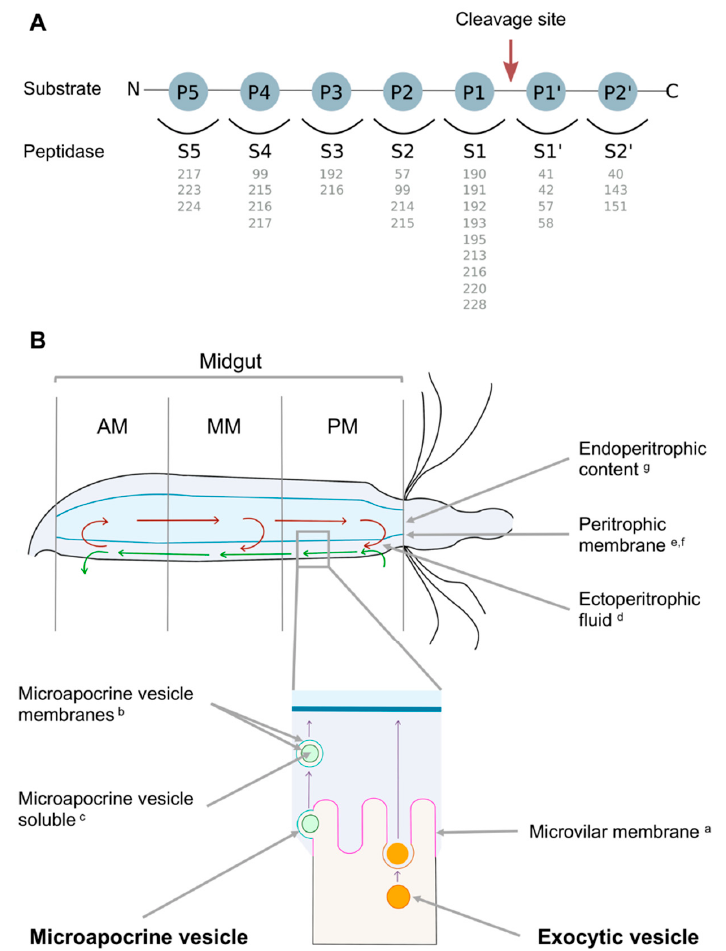
Figure 1. The peptidase subsites and Spodoptera frugiperda midgut regions explored in this work. ( A ) Substrate positions (P5, P2’) and corresponding peptidase subsites (S5, S2’) in the substrate-binding site. The residue positions belonging to each subsite are listed in gray below the subsite. ( B ) Schematic view of the Spodoptera frugiperda gut and the midgut regions analyzed by RNA-seq (anterior (AM), middle (MM), and posterior (PM) midgut) and proteomic analysis: a microvillar membrane, b microapocrine vesicles, c microaprocrine vesicle soluble, d ectoperitrophic fluid, e,f peritrophic membrane wash and core, and g endoperitrophic content. Red arrows, enzyme flux; green arrows, water flux.